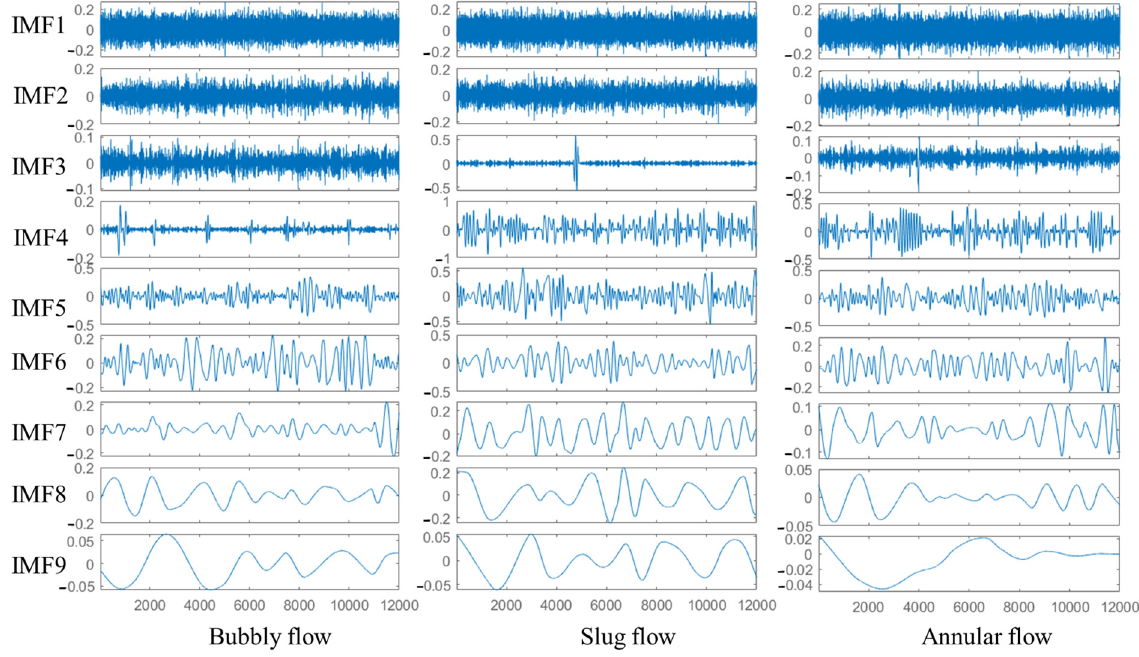
Figure 7. IMF components of different flow patterns. Table 3. Distributions of EMD energy spectrum on levels 1–3.